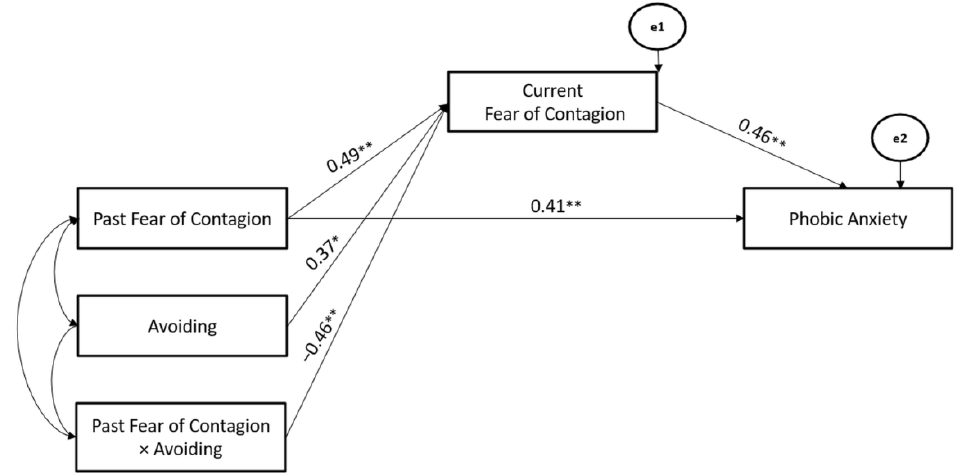
Figure 9. The Mediated-Moderated model of Past and Current Fear of Contagion stressors, Avoiding Coping Strategy, and Phobic Anxiety. ** p < 0.01; * p < 0.05.